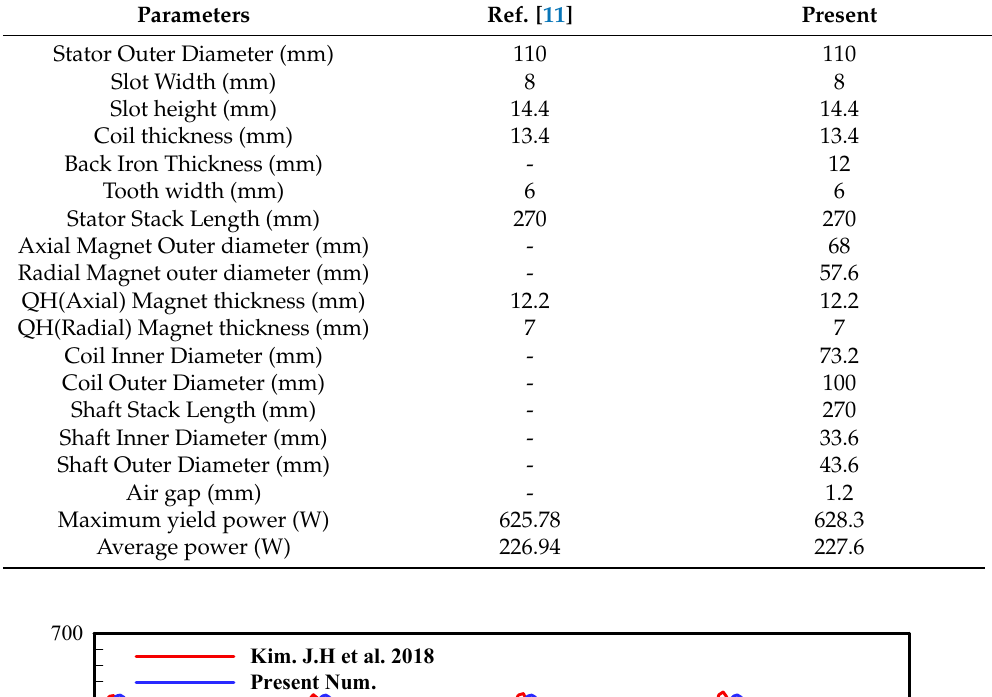
Table 4. Specifications of the model designed by Ref. [11].